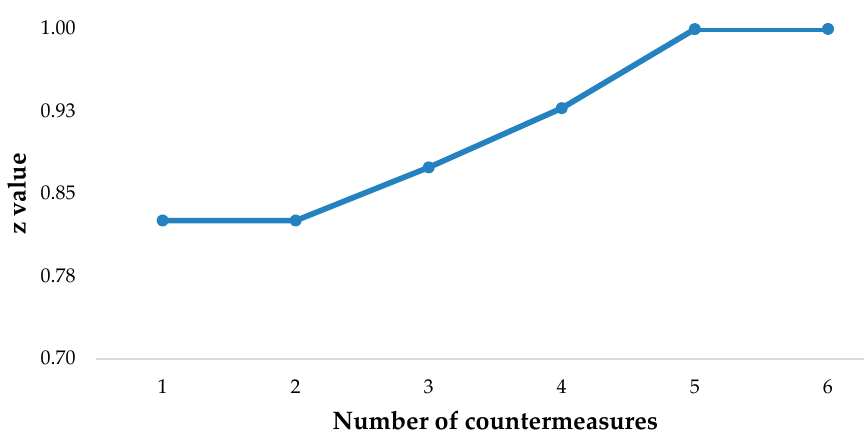
Figure 9. Countermeasures and their corresponding least membership function values.